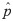
Implied biased probability p^ versus threshold K for a range of values for q.For a range of q values, representing the pulse-coupling probability parameter, from q = 0.8 to q = 1.05, a random agent from a population of agents each with identical threshold K, is selected and its mean hitting time to the threshold is computed from 10,000 simulations. Using Eq (18), the implied bias probability, p^, is then computed. For every K value tested, p^ attains its maximum value when q = 1.